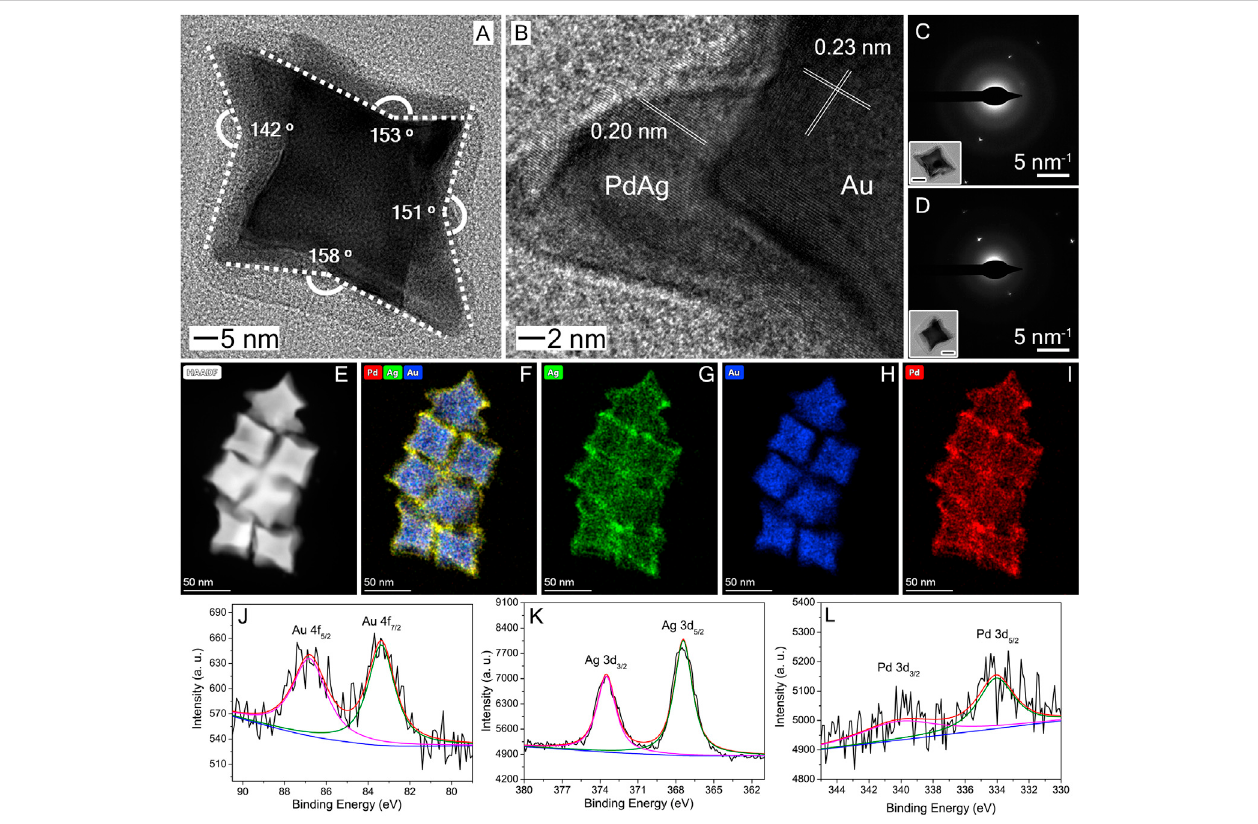
FIGURE2| MorphologyandstructuralcharacterizationsofAu@PdAgcore-shellconcavenanocubes: (A) TEM; (B) HRTEM; (C,D) SAED; (E) HAADF-STEM; (F – I) EDX-STEM elemental mapping: (F) overlap of Au, Pd, and Ag, (G) Ag, (H) Au, (I) Pd; (J – L) XPS spectra: (J) Au 4f; (K) Ag 3d; (L) Pd 3d. The insets in (C, D) shows the corresponding particle, with a scale bar of 10